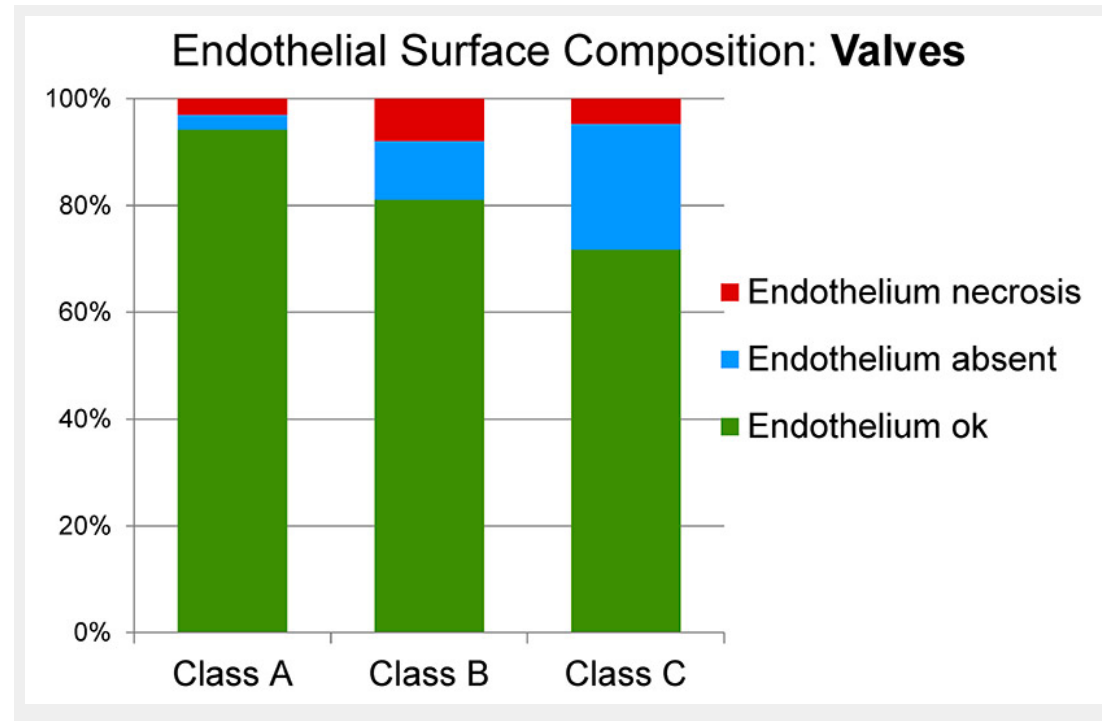
Figure 6 Surface analysis of the endothelium of the valve in the three classes of venous disease (A: minimal; B: early stage; C: advanced).